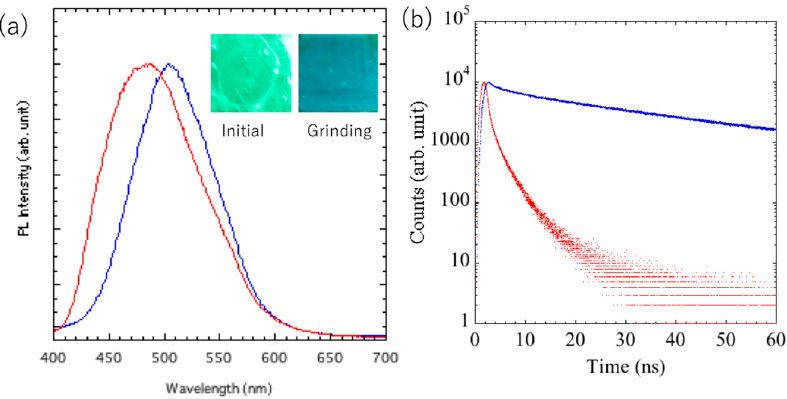
Table 1. Gel-formation tests for 2ECh in various solvents.